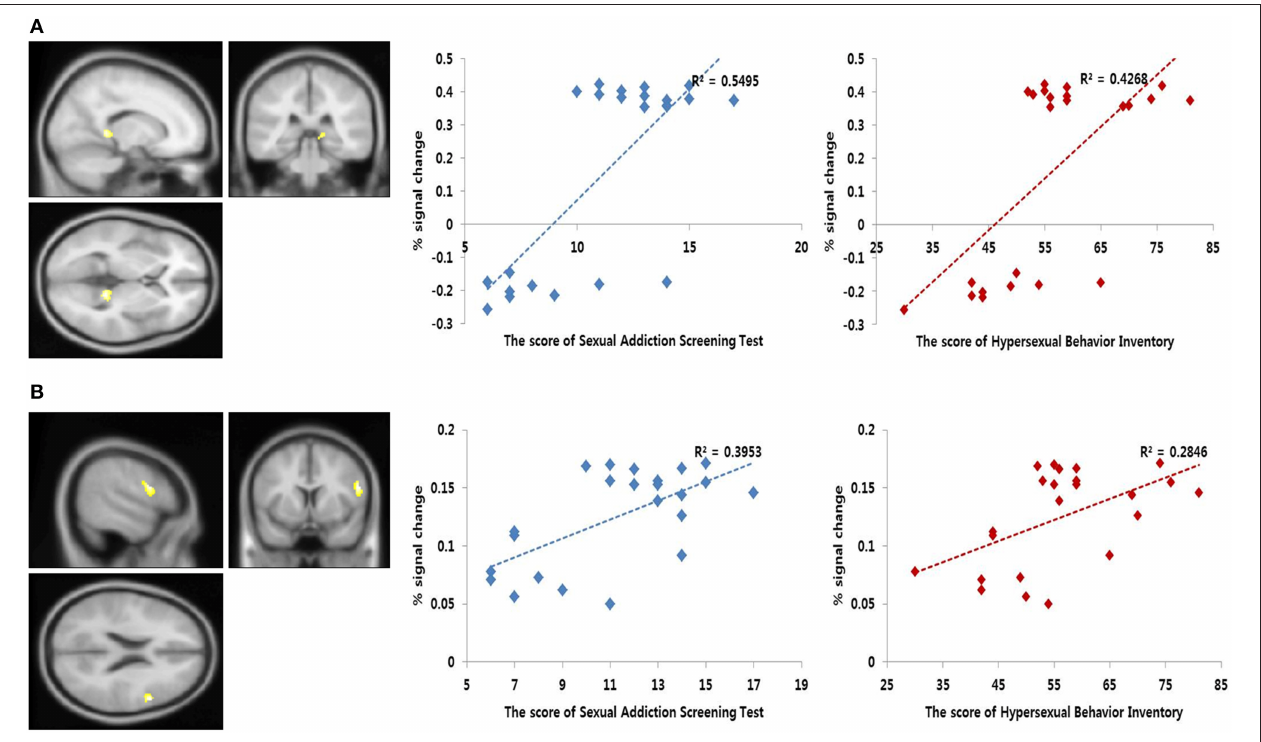
FIGURE 4 | Results of the correlation analysis. Left, functional magnetic resonance imaging (fMRI) correlational analysis. The regions showing significant correlation between the brain activity during sexual desire and the Sexual Addiction Screening Test-R (SAST-R) scores ( p < 0.001 , uncorrected). Right, linear relationship between the percent signal changes extracted from each area and sexual severity scores [i.e., SAST-R and Hypersexual Behavior Inventory (HBI) scores]. The x-axis shows the sexual severity scores, and the y-axis represents the percent signal change. (A) Bilateral thalamus (MNI coordinate; x = 4 , y = − 32 , z = 6 ) (B) Right dorsolateral prefrontal cortex (MNI coordinate; x = 56 , y = 8 , z = 22